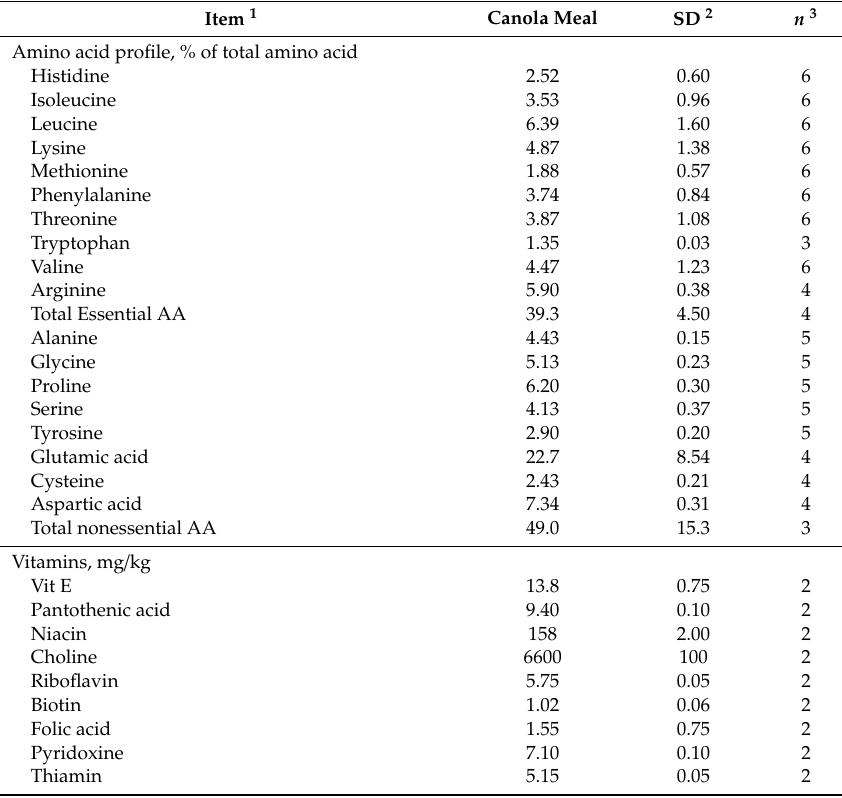
Table 2. Micronutrient chemical composition of canola meal. Item 1 Canola Meal SD 2 n 3 Amino acid profile, % of total amino acid